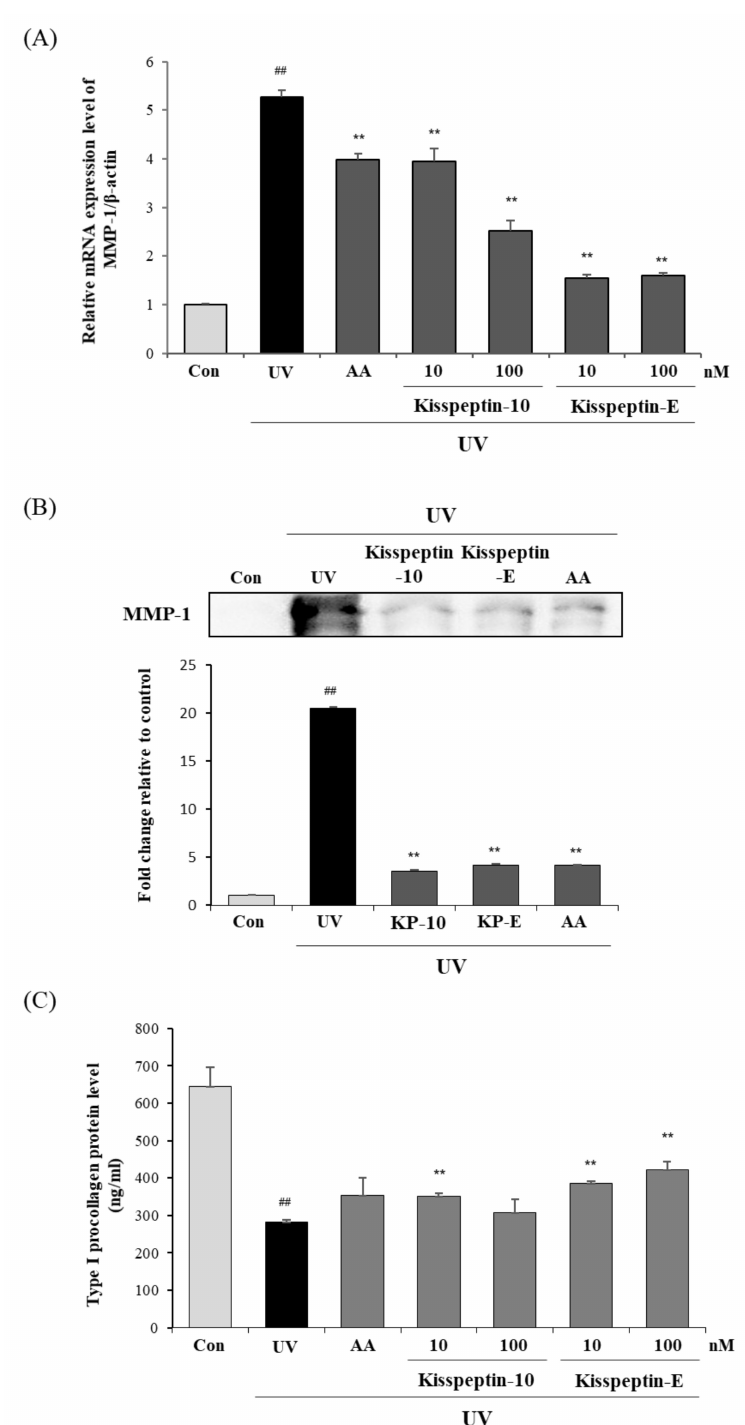
Figure 3. Kisspeptin-mimicking peptides decreased the mRNA and protein expression of MMP-1 whereas increased the production of type I procollagen in UVB irradiated Hs68 fibroblasts. The Hs68 fibroblasts were treated with Kisspeptin-10 and Kisspeptin-E for 24 h after UVB irradiation. AA was used as a positive control (10 µ g / mL). The mRNA ( A ) and protein ( B ) expression of MMP-1 were measured by RT-qPCR and immunoblot, respectively. ( C ) The type I procollagen protein secretion was measured by ELISA assay. The means ± SEs are the average of three independent experiments. KP-10, Kisspeptin-10; KP-E, Kisspeptin-E; AA, Ascorbic acid; ## p < 0.01 indicates a significant di ff erence from the control. ** p < 0.01 indicates a significant di ff erence from the UVB-induced